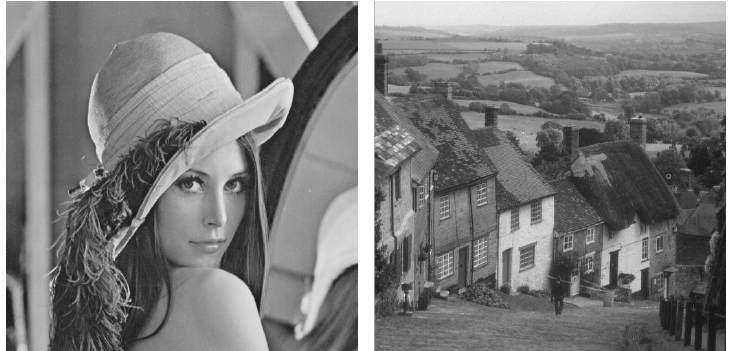
Figure 4. Input images: Lena and Gold Hill. Size: 512 × 512 pixel each